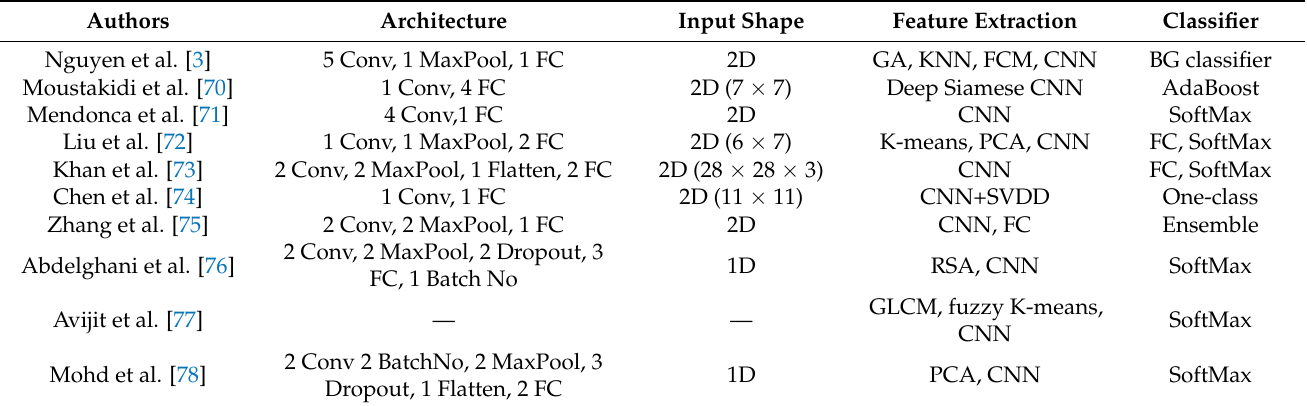
Table 12. Architectural properties of group 4 (Hybrid CNN and Machine Learning) IDS